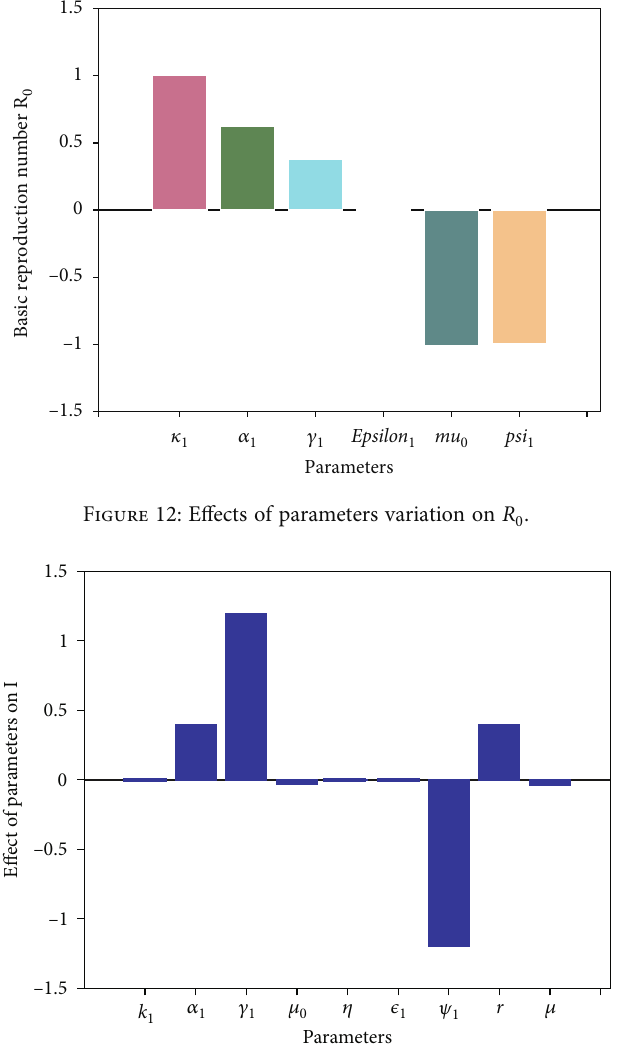
Figure 13: E ff ects of model parameters on infected individuals when the density of infected individual is maximum after 3 years. Table 3: Parameters and values used in model (1) –